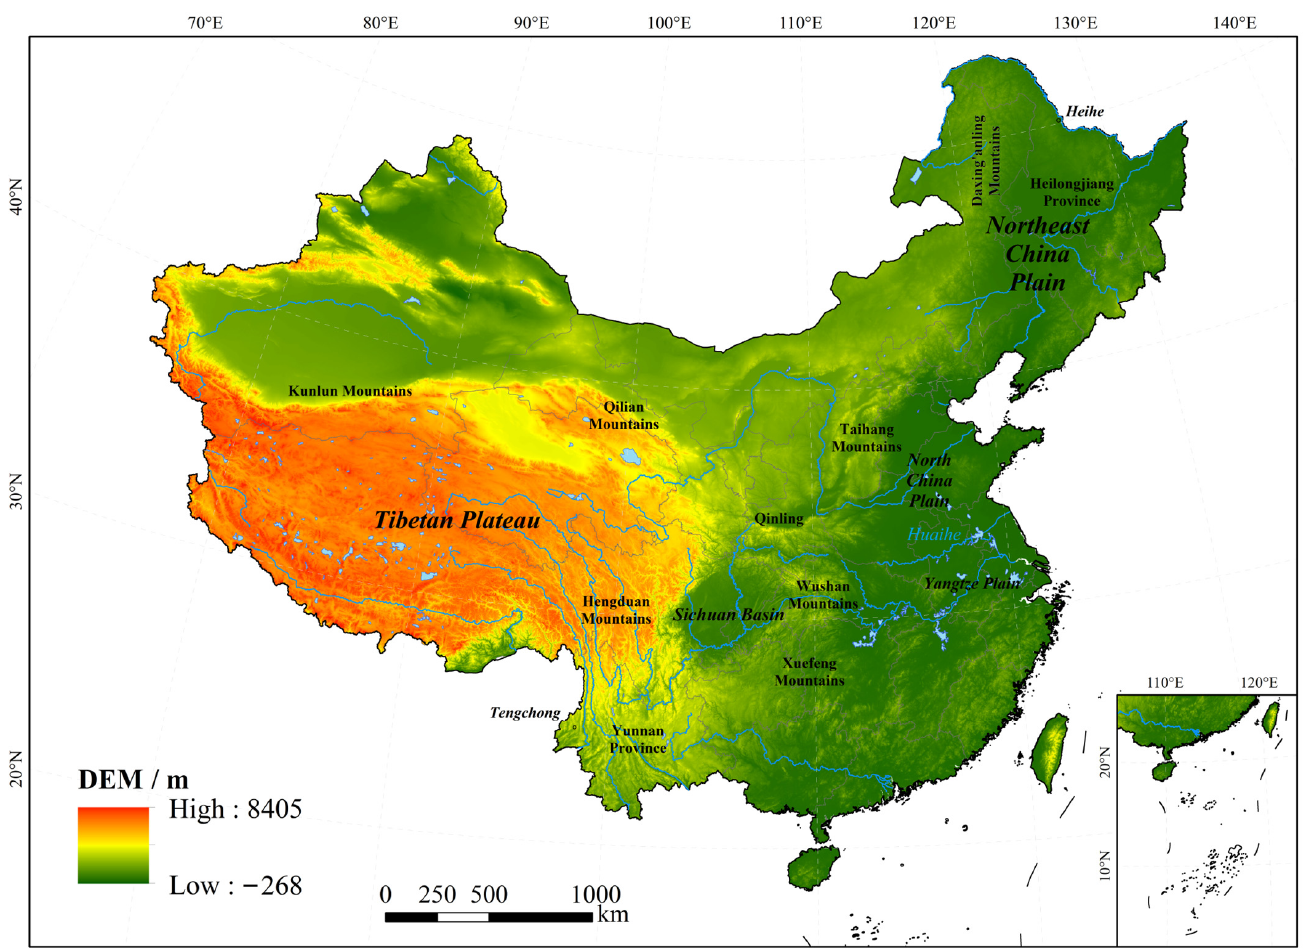
Figure 1. Natural topography of China with indications of the important toponyms mentioned in this